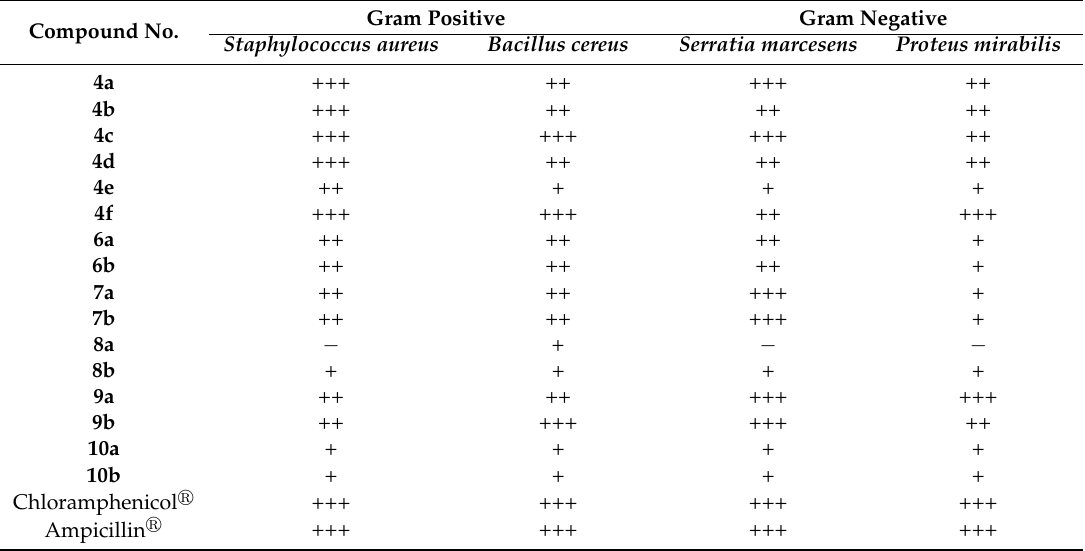
Table 1. Antibacterial activity of the synthesized compounds: Agar diffusion